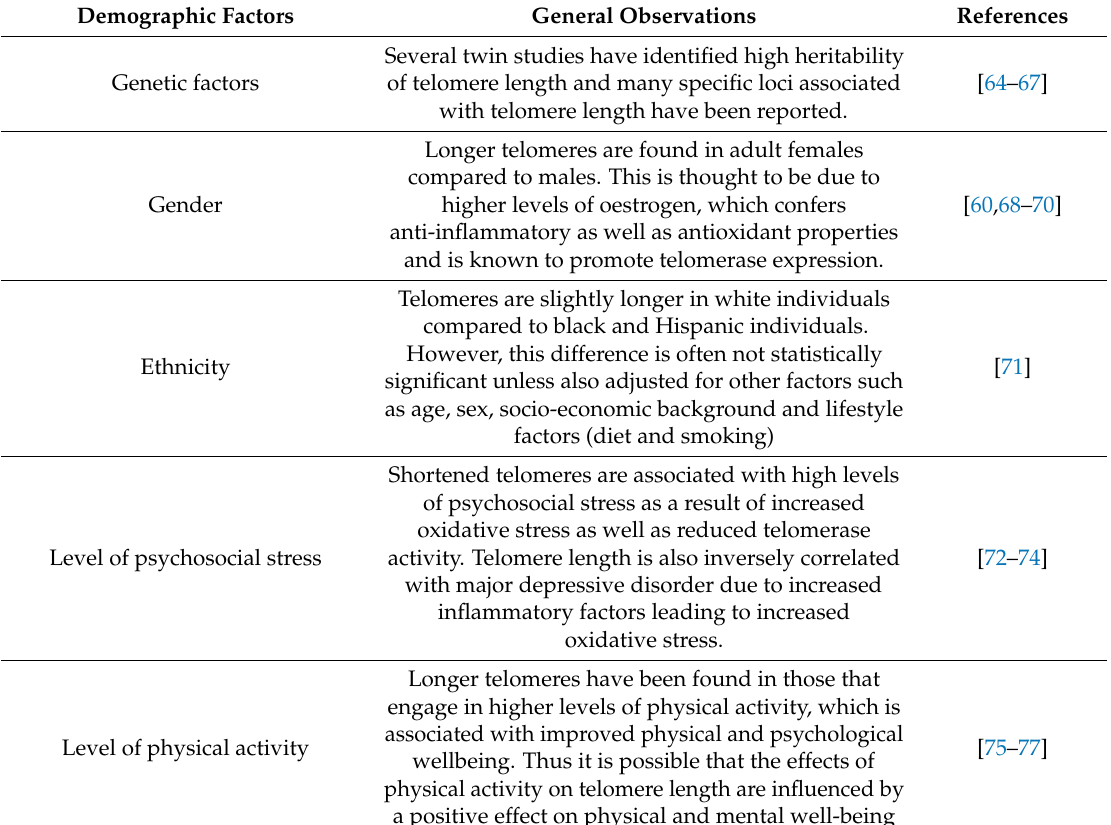
Table 2. Demographic factors affecting telomere length: An overview of current findings and references. Demographic